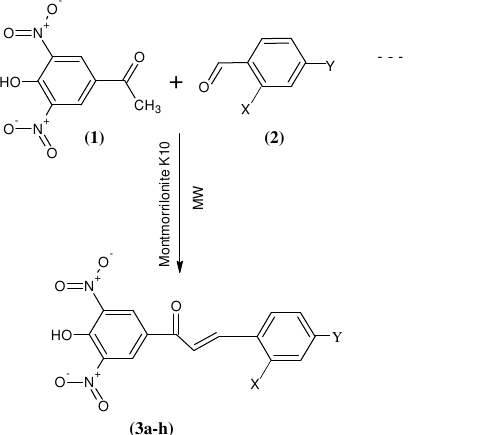
Figure 1. Scheme of the synthesis of chalcones ( 3a – h )